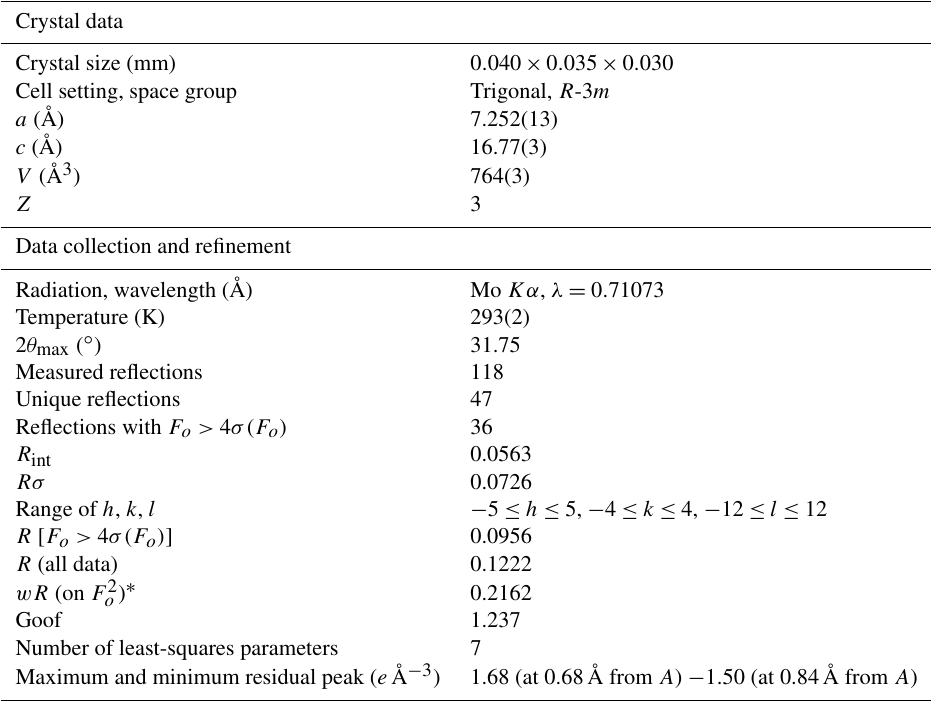
Table 3. Summary of parameters describing data collection and refinement for graulichite-(La).